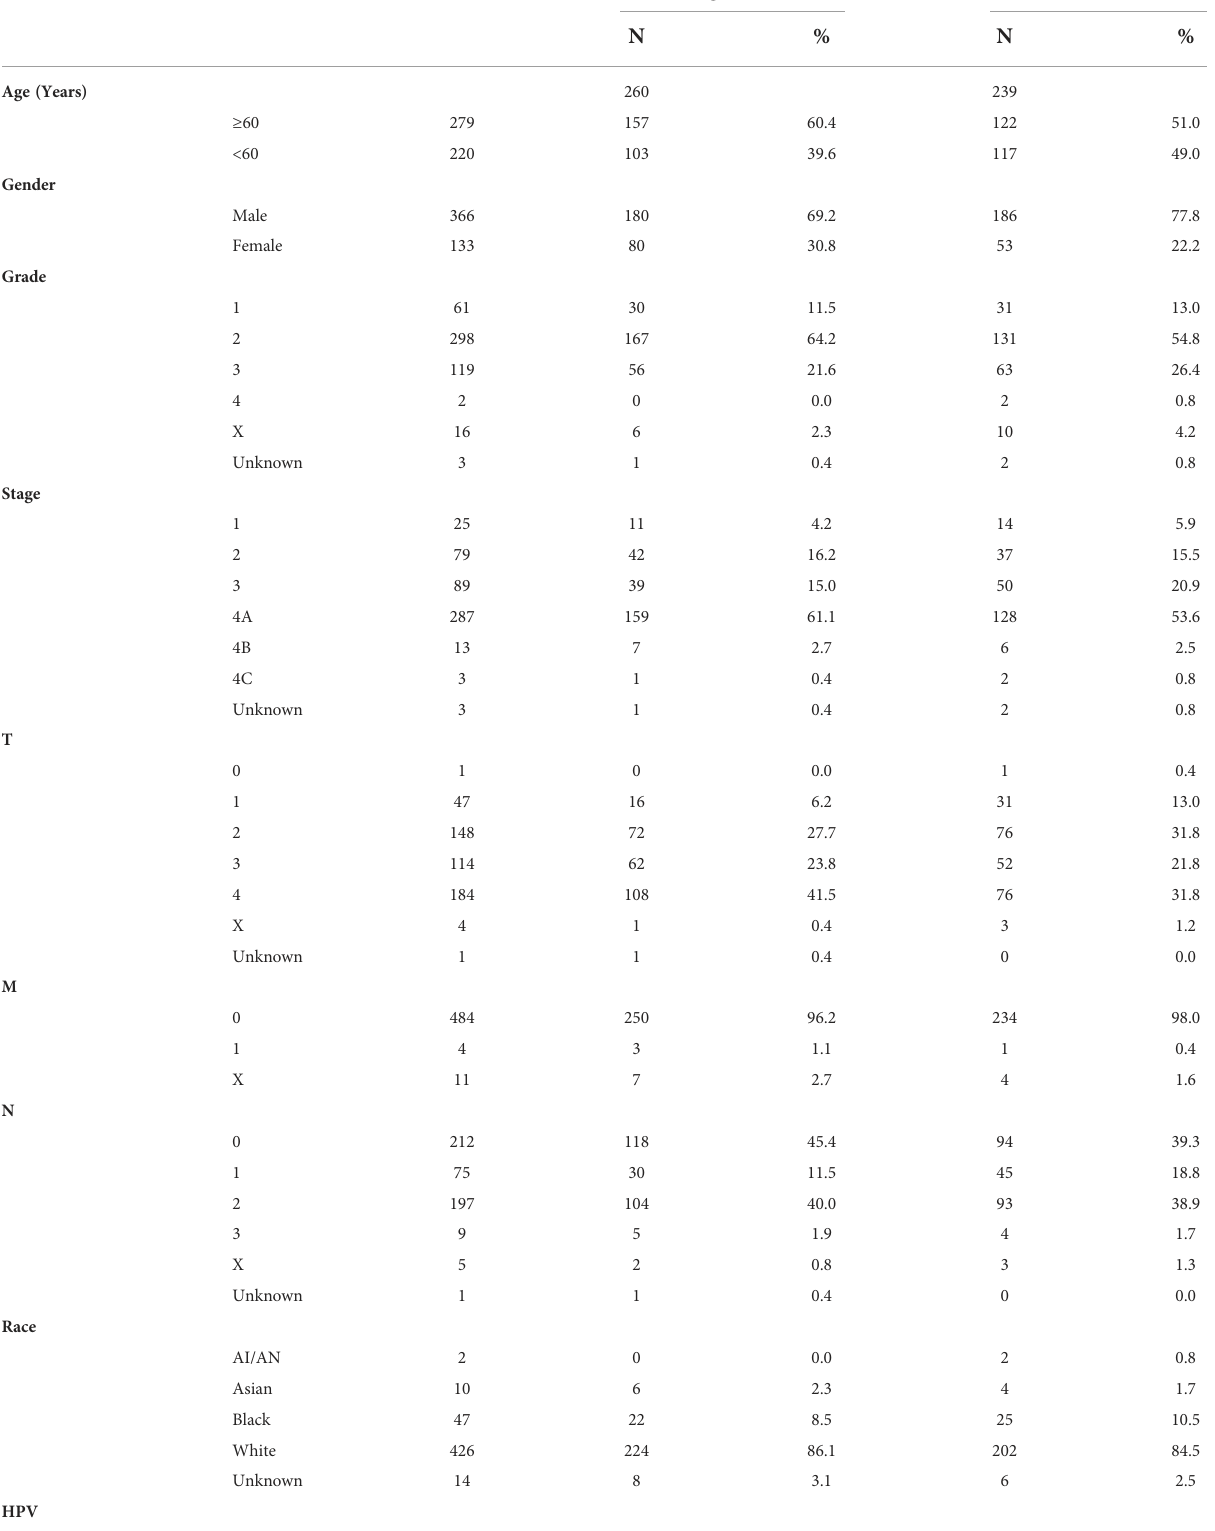
TABLE 1 Demographic data from TCGA